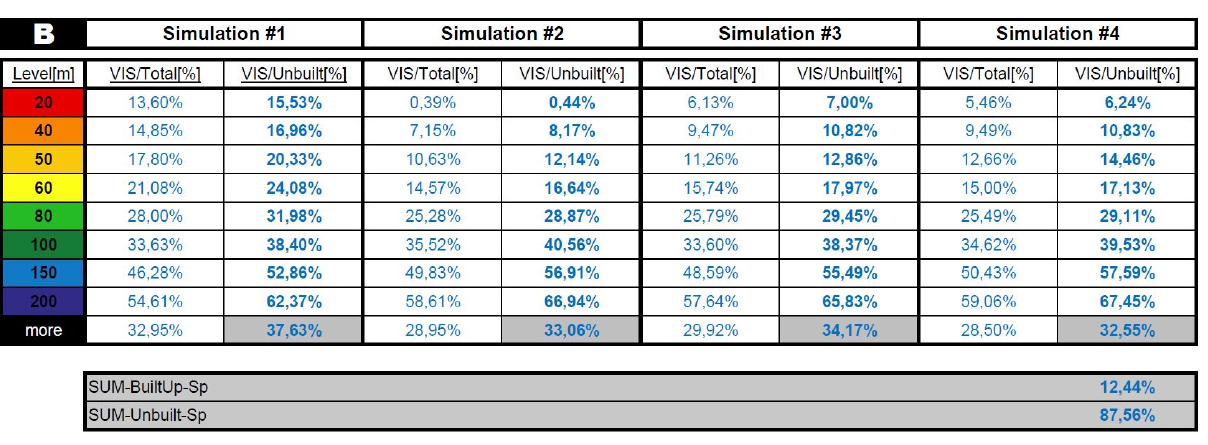
Table 2. VIS simulations for area B